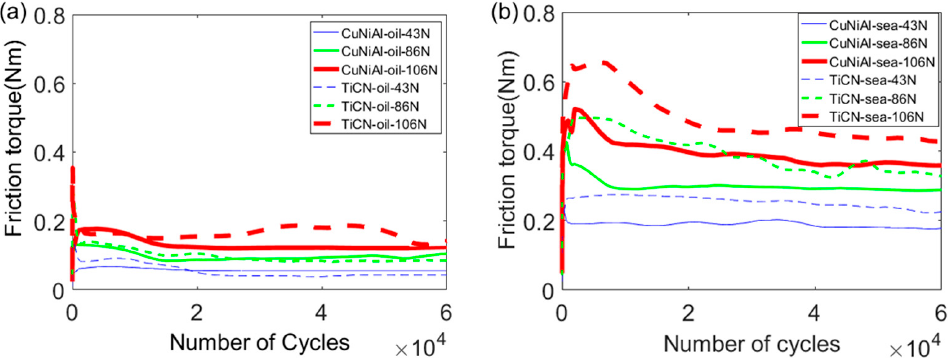
Figure 8. Friction torque curves: ( a ) in oil; and ( b ) in artificial seawater.